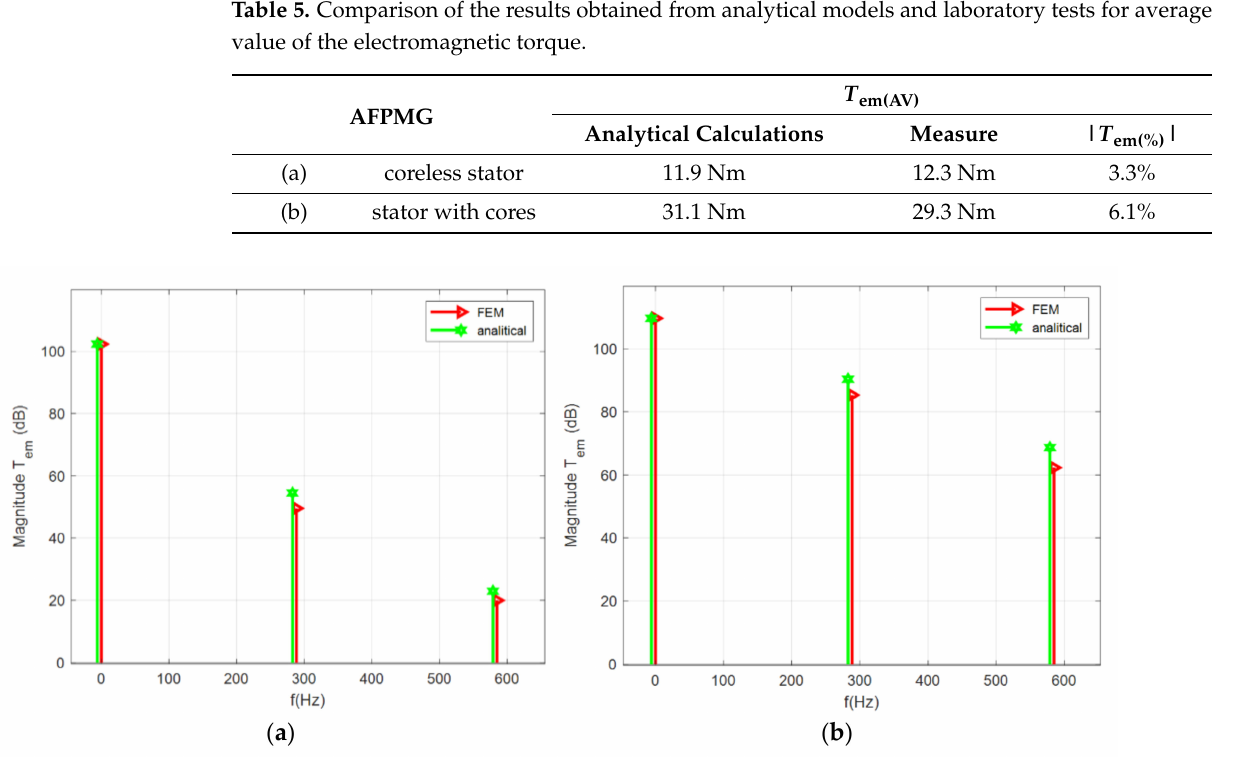
Figure 11. FFT spectrum of electromagnetic torque ( a ) AFPMG—coreless stator ( b ) AFPMG—core